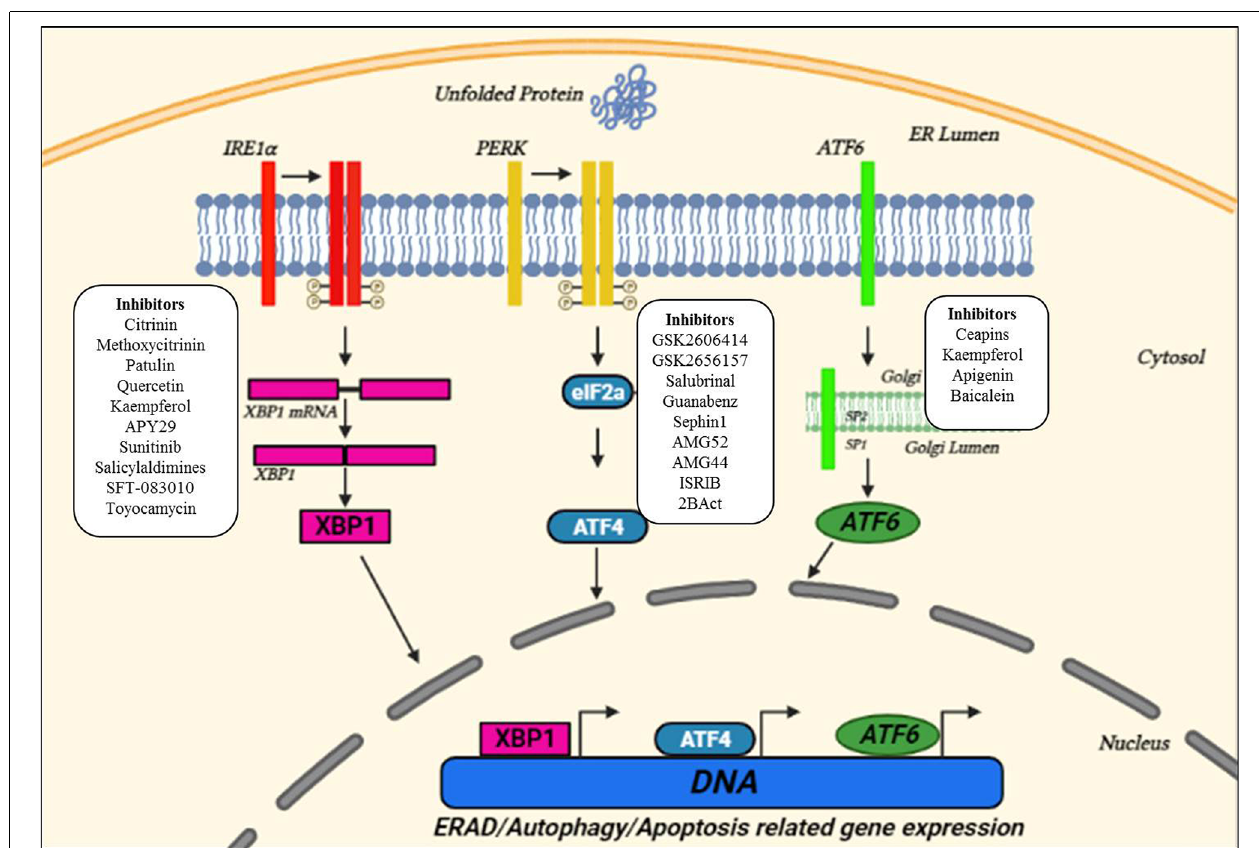
FIGURE 1 | Unfolded protein response (UPR) pathways in the ER and small molecule interventions. Upon ER stress, the ER launches three adaptive pathways through IRE1 α , PERK, and activating transcription factor 6 (ATF6), collectively called as the UPR, to restore proteostasis. All these three ER stress sensors activate signaling cascades, increasing protein-folding ability and decreasing ER stress. Small molecules targeting three key UPR signaling components are also indicated in the figure suggesting the sites for therapeutic interventions. Adapted and modified from Webster et al.